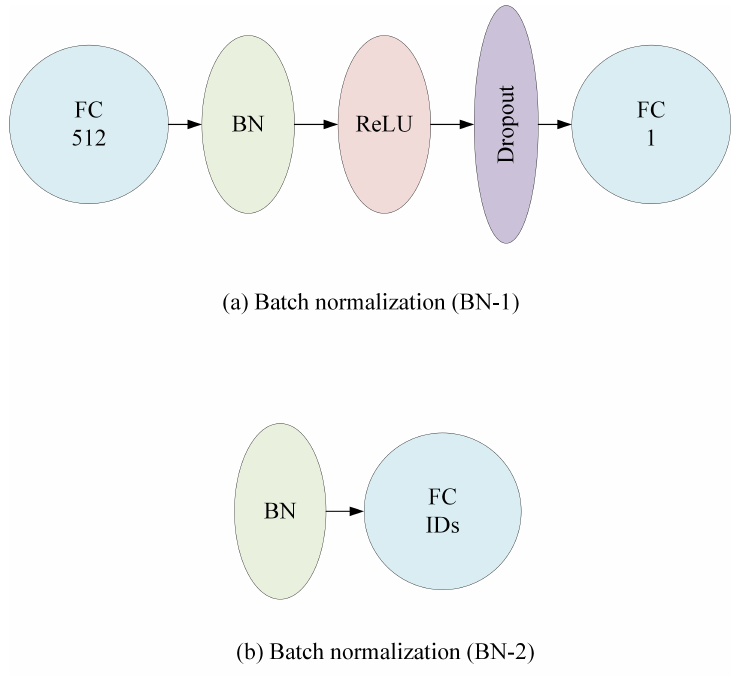
Figure 4. Batch normalization modules are used for different tasks. We design two modules: BN-1 for attribute recognition and BN-2 for identity recognition. “IDs” is the number of all different